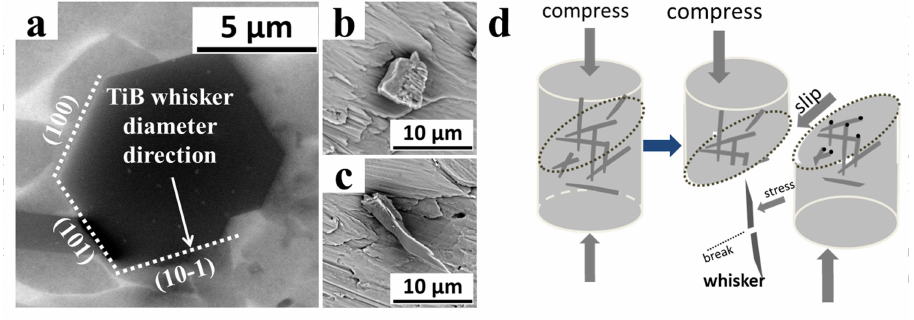
Figure 10. ( a ) The hexagonal cross section of the in situ TiB whisker; ( b , c ) TiB whiskers on the sliding surface; ( d ) The fracture form of the TiB whiskers during the slip of the compression.